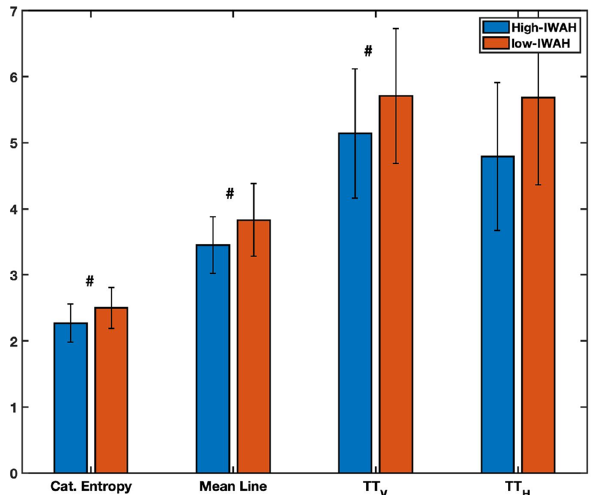
Figure 4. Average CRQA parameters for the high- and low-IWAH groups. Statistical trends ( p < 0.1) are marked by